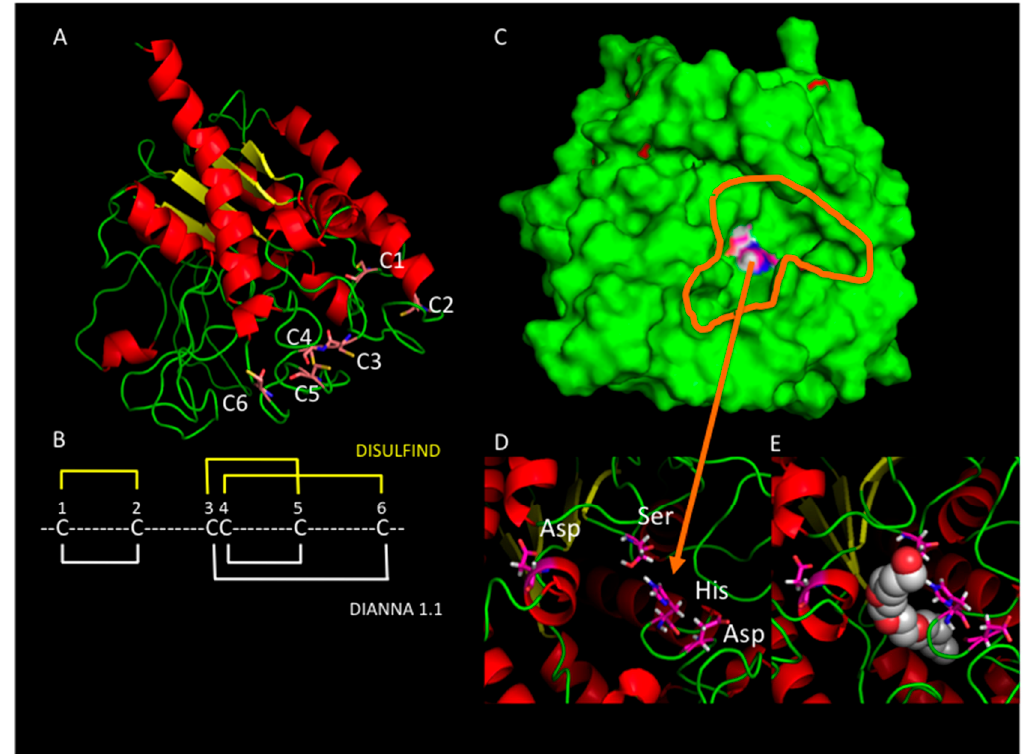
Figure 3. 3D structure of tomato cutin synthase obtained by homology modelling and showing the catalytic triad and a putative lipid binding cavity. A : a 3D structure model of tomato CUS1 highlighting the cysteine motif. B : prediction of cysteine pairings using DIANNA 1.1 (http://clavius.bc.edu/~clotelab/DiANNA/) and DISULFIND (http://disulfind.dsi.unifi.it/) softwares. C : a 3D structure model of tomato CUS1 highlighting a cavity where the amino acids of a putative catalytic triad (Ser, Asp, His) are seen in blue and white. D : the putative catalytic triad (Ser9, Asp300, His303) and the highly conserved Asp143 residue. E : the catalytic site filled with a detergent molecule (C8E4) as in the template crystallographic structure of the GDSL-lipase domain of a bacterial autotransporter (pdb: 3kvn). By reducing the protein polymorphism on the criteria defined previously, different clades were highlighted that contain other GDSL-lipases (Figure